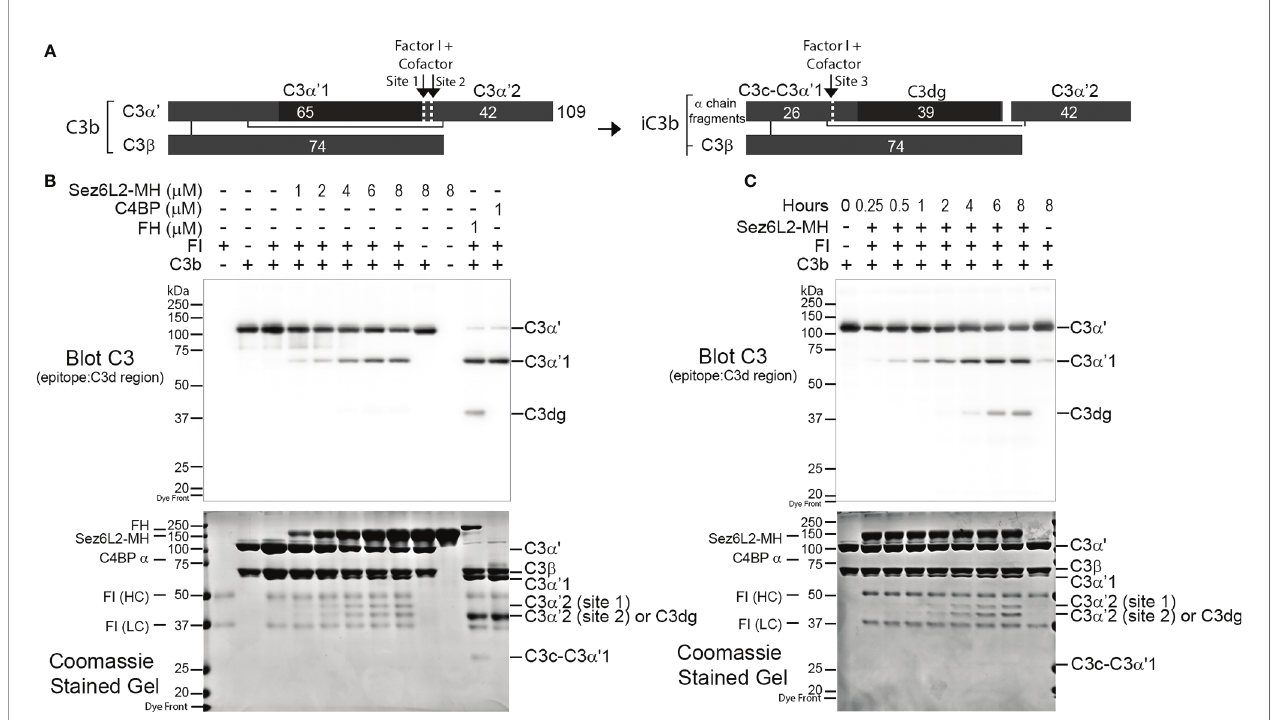
FIGURE 5 | Truncated Sez6L2 is a cofactor for Factor I cleavage of C3b. (A ) Schematic of Factor I and cofactor cleavage of C3b and iC3b. (B) C3b and Factor I (FI) were incubated alone, with concentrations of Sez6L2-MH ranging from 1 to 8 µM, or with 1 µM Factor H (FH) or C4BP for two hours at 37°C. Then samples were analyzed by western blot using antibodies that recognize C3d, a region within the C3 a chain [and highlighted by the black rectangle in the schematics in (A) ]. Coomassie stained gels are also shown. Sez6L2-MH supports partial FI cleavage of C3b at sites 1 and 2 generating the cleavage products C3 a ’ 1 and C3 a ’ 2 in a concentration dependent manner. FH and C4BP (known co-factors of FI towards C3b) supported almost full cleavage of C3b at sites 1 and 2. FH also showed partial cleavage at site 3 generating some C3dg and C3c-C3 a ’ 1. (C) C3b and FI were incubated with 1.5 µM Sez6L2-MH for 0.25-8 hours and then were visualized by western blot and Coomassie stained gels. Sez6L2-MH facilitates more FI cleavage with increased time including some partial cleavage at site 3 to generating C3dg and C3c-C3 a ’